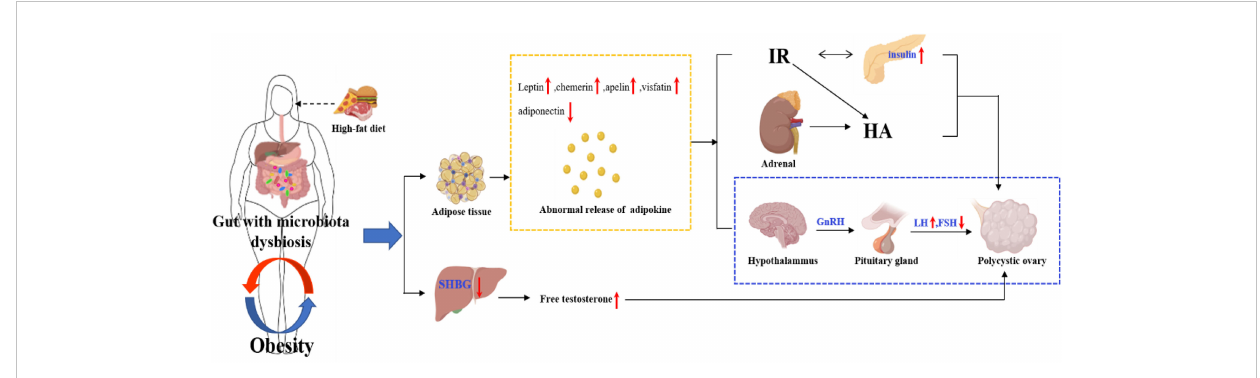
FIGURE 4 The internal relationship between obesity, intestinal fl ora and